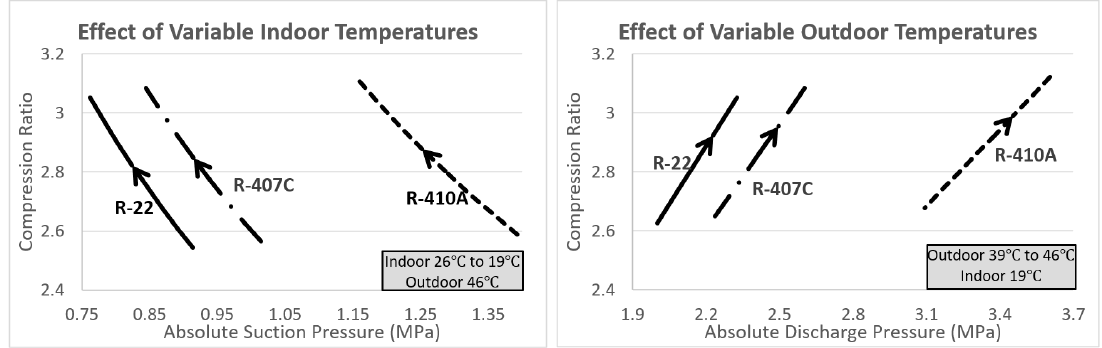
Figure 5. Effects of variable outdoor and indoor temperatures on compression ratio. Table 6. Effects of variable outdoor and indoor temperatures on the compression ratio (CR).